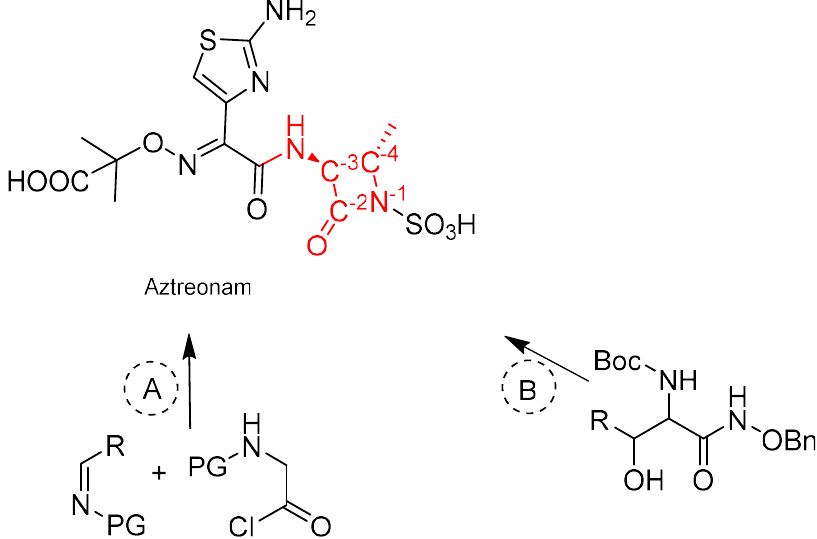
Figure 1. Typical synthetic routes to known C-4-substituted 3-amino-ß-lactams with antibacterial activity (( A ) Staudinger [2+2] cyclocoaddition, ( B ) Mitsunobu-mediated cyclization, ( C ) bromine- induced cyclization).